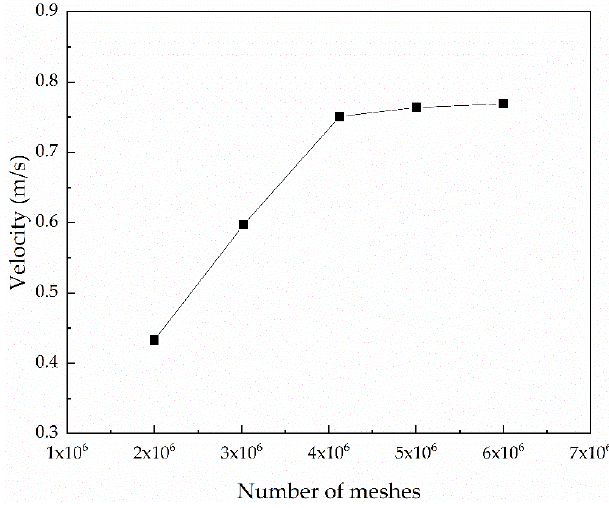
Figure 5. Mesh independence